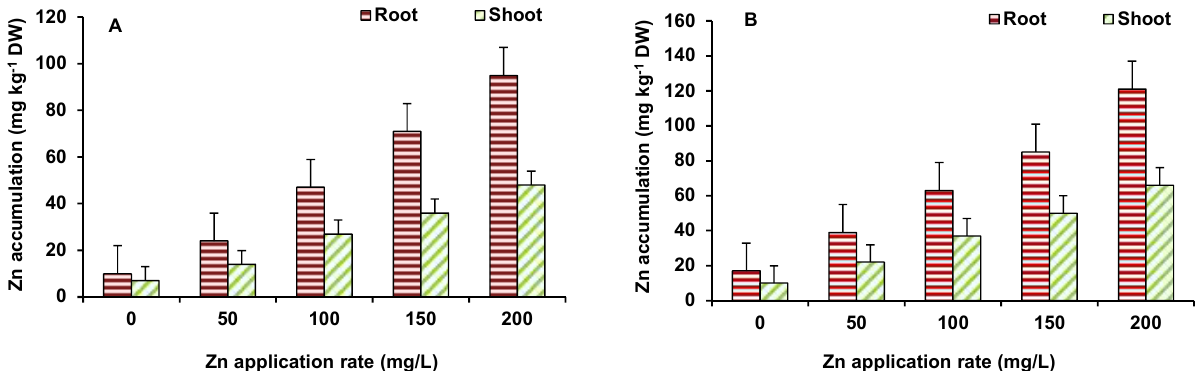
Figure 5. Effect of ZnO NP treatment on Zn accumulation in maize ( A ) and wheat ( B ). Values are means of four replicates. Error bars indicate the least significant value (LSD) at p ≤ 0.05 among the treatments.